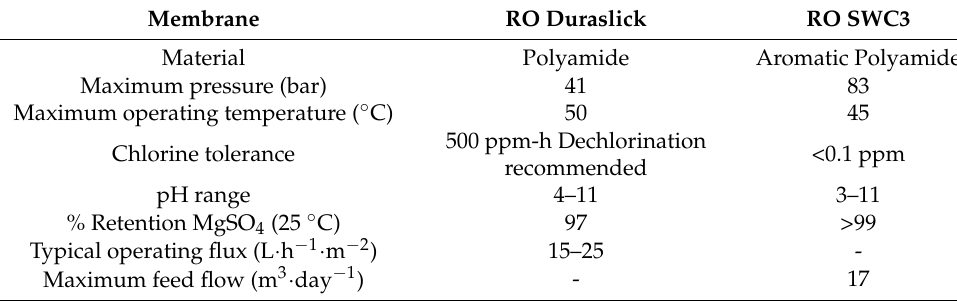
Table 3. Characteristics of the RO membranes.